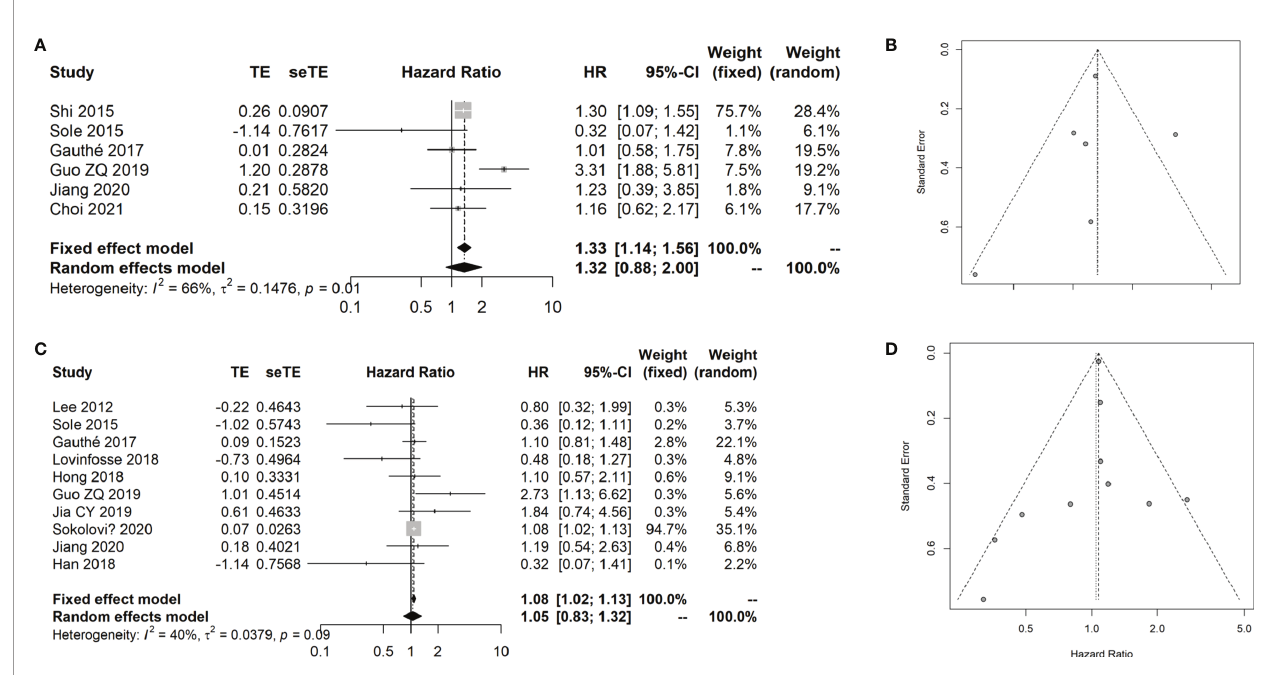
FIGURE 6 | Meta-analysis for the prognostic value of SUVmax in CRC cancer. (A) Forest plot for the association of SUVmax with OS. (B) Funnel plot for the publication bias of OS data. (C) Forest plot for the association of SUVmax with DFS/PFS. (D) Funnel plot for the publication bias of DFS/PFS